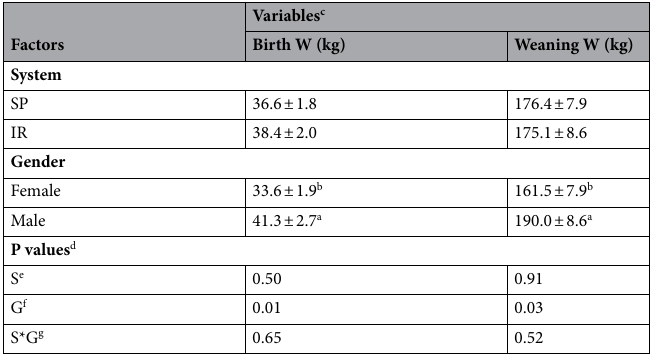
Table 2. Least square mean ± standard error of the calf’s weight at birth and weaning according to gender and system (SP: silvopastoral; IR: intensive rotational grazing). a,b = means followed by different lowercase letters on the same column are significant. c Birth W weight at birth, Weaning W weight at weaning, d P values < 0.05 were considered significant; e S system, f G gender, g S*G interaction between system and